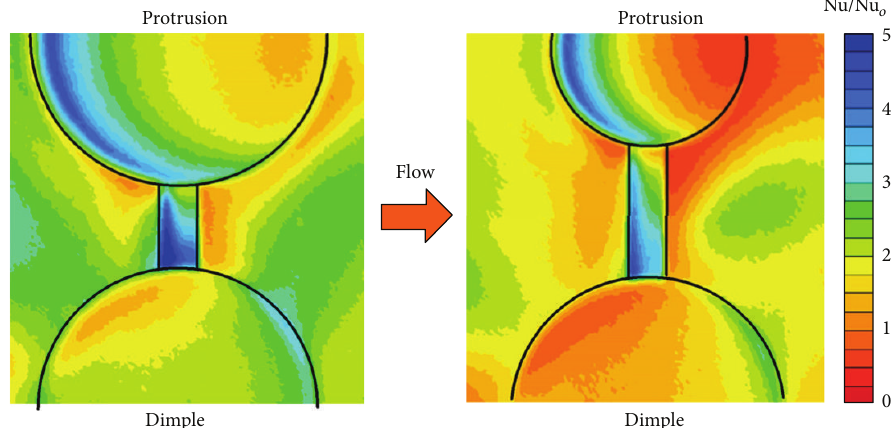
Figure 17: Local Nusselt number ratios for the rib, dimple, and protrusion arrangement employed in the investigation by Murata et al. [4] for Re = 2,000 and two different protrusion sizes.